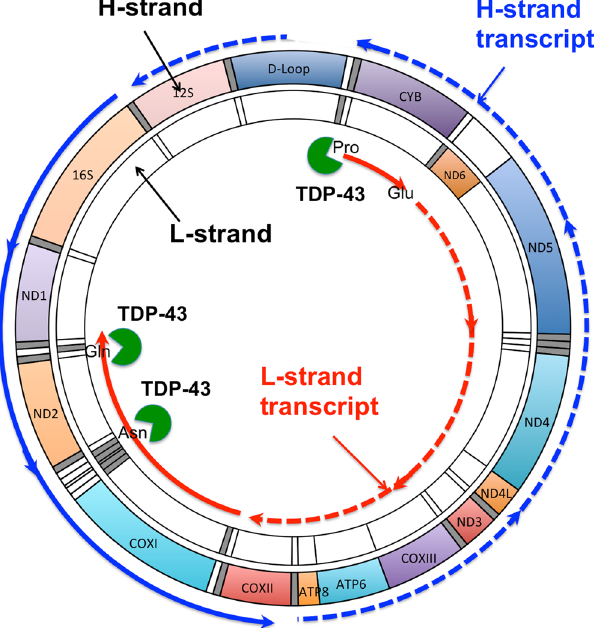
Figure 8. Hypothetical scheme for the effect of increased TDP-43 level on mt polycistronic transcripts. Overexpression of TDP-43 causes an increase in TDP-43 level in mitochondria. The excess TDP-43 stabilises the L-strand transcript (dashed red line) by binding directly to regions corresponding to mt-tRNA Pro (Pro), mt- tRNA Asn (Asn), and mt-tRNA Gln (Gln), and the resulting L-strand-derived transcript (solid red line), and then stabilises one of the transcripts from the H-strand (solid blue line) via complementary double-stand formation. The increased TDP-43 level in mitochondria thereby causes unbalanced processing the mt-transcript, resulting in deregulation of mitochondrial protein